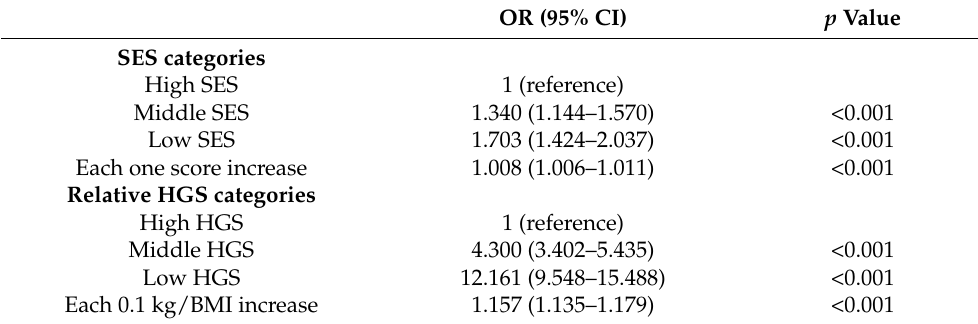
Table 4. Odds ratio for NAFLD risk by socioeconomic status and relative handgrip strength.